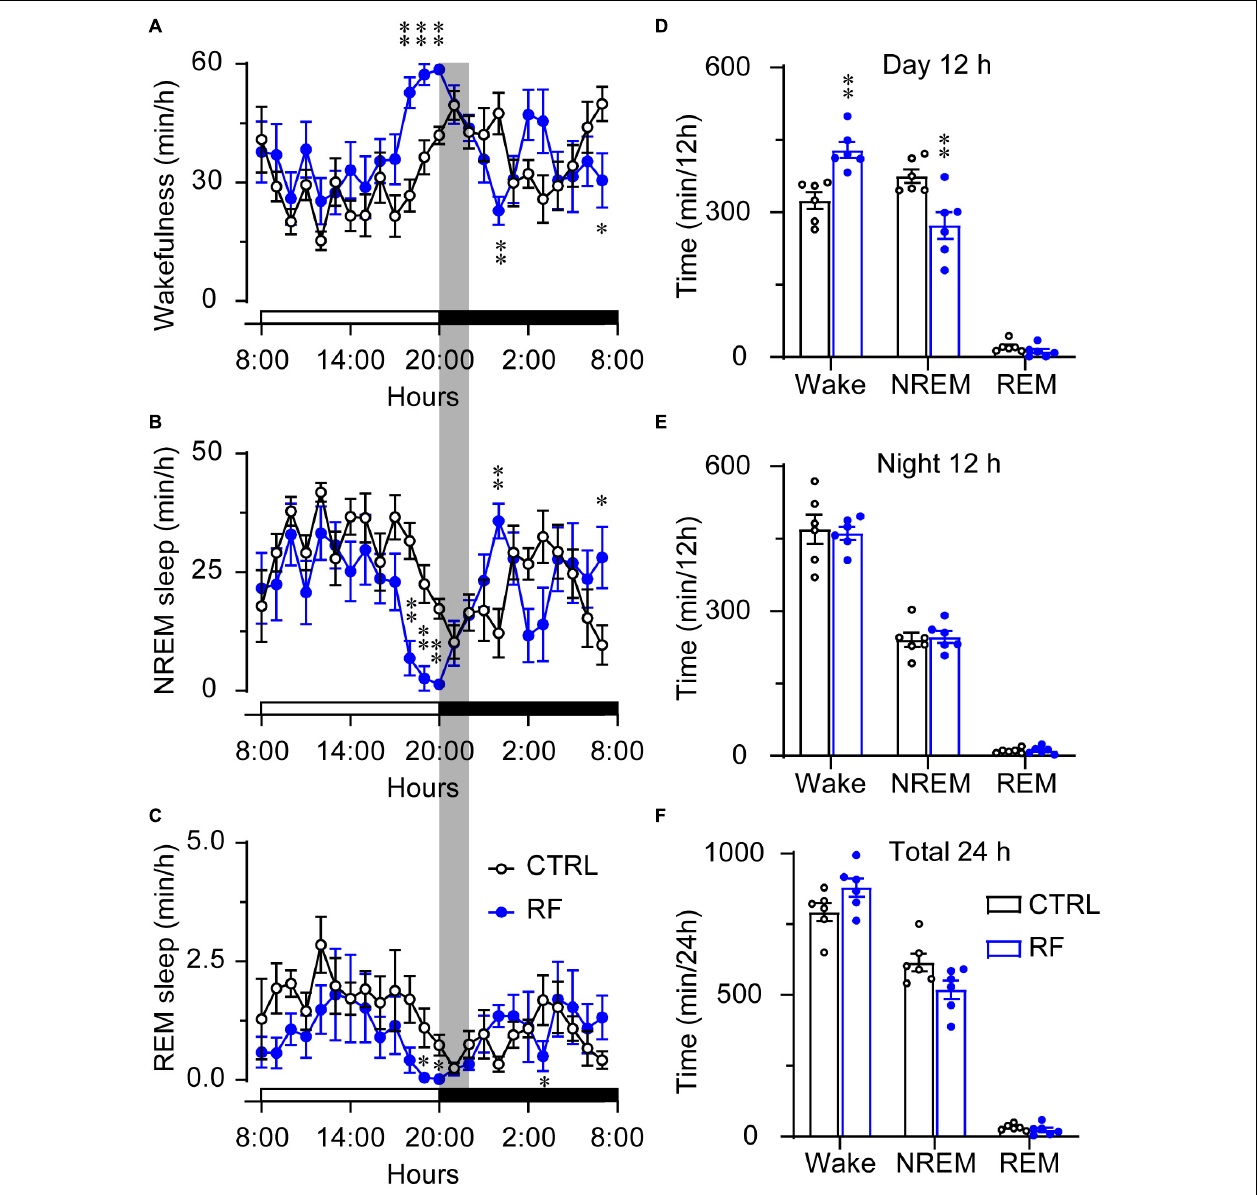
FIGURE 4 | Time the mice in the RF and CTRL groups spent in sleep-wake stages on day 14 of the RF protocol. Time course of wakefulness (A) , NREM sleep (B) , and REM sleep on day 14 of the RF protocol (C) . Cumulative time of wakefulness, NREM sleep, and REM sleep during the light period (D) , dark period (E) , and 24-h period (F) . The gray box indicates food availability during the dark period. Open and closed bars above the x -axis indicate light and dark periods, respectively. ∗ p < 0.05, ∗∗ p < 0.01 versus CTRL, n = 6. CTRL, control; RF, restricted